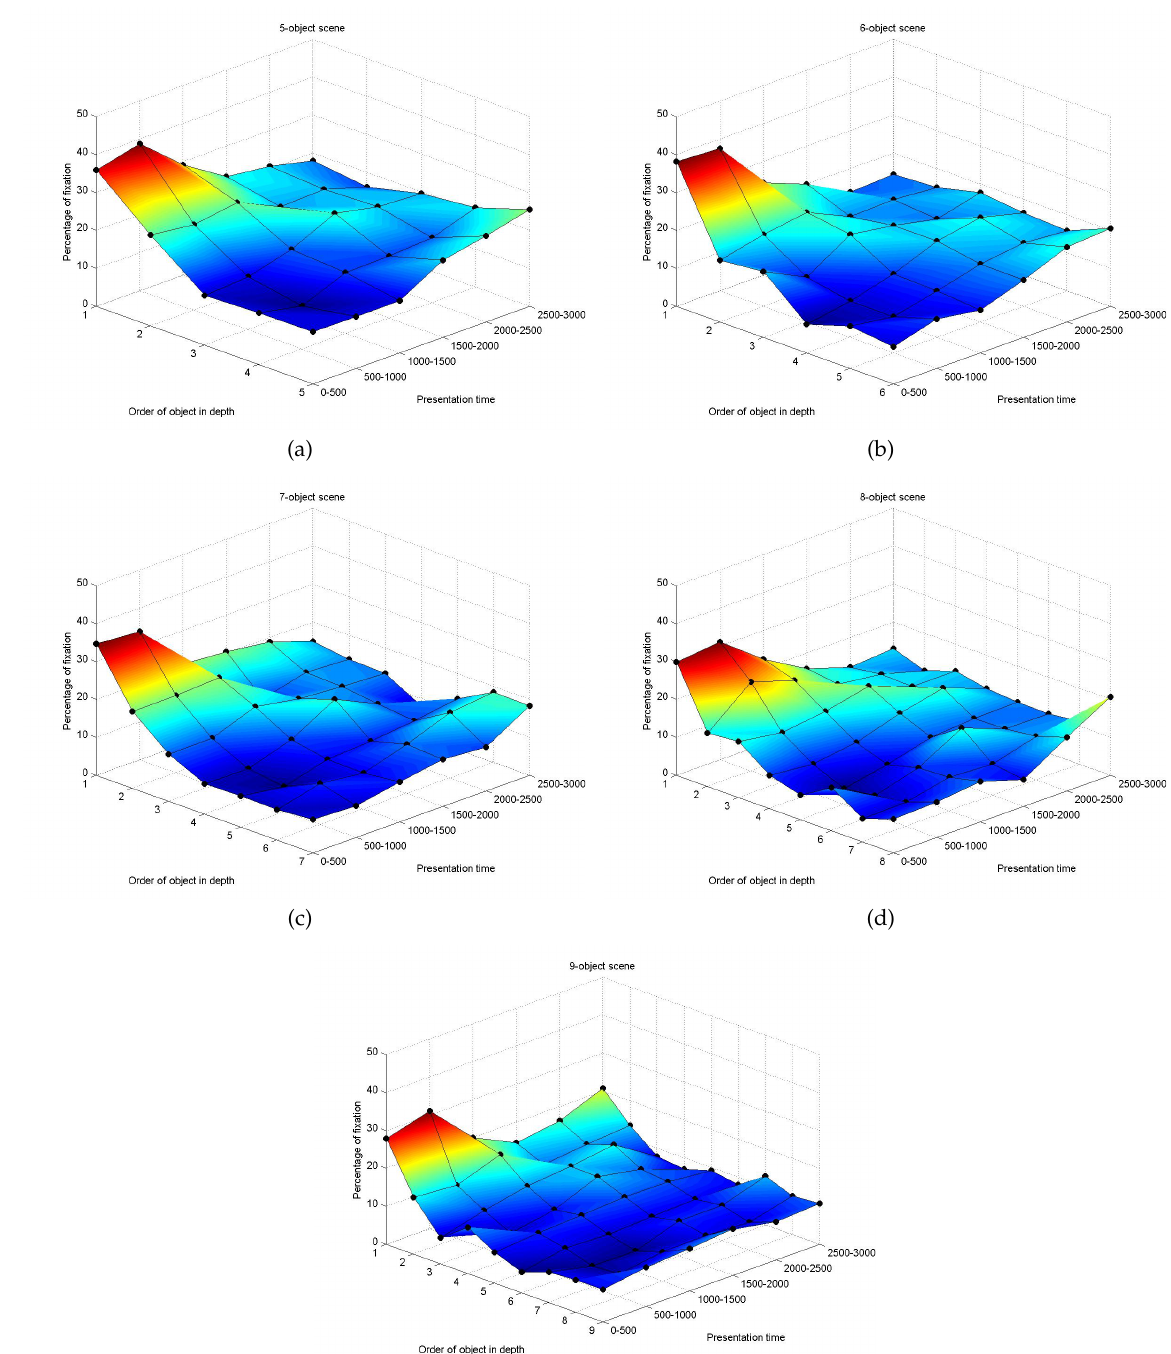
Figure 7 . Variation of fixation distribution as a function of presentation time. The five sub figures represent five type of scenes which contain different numbers of